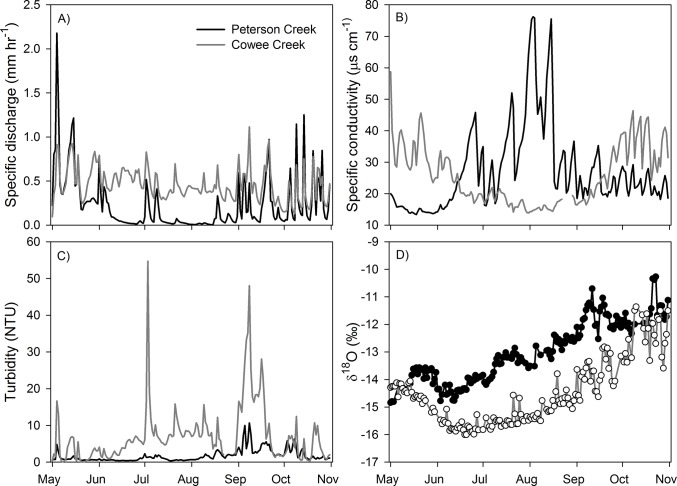
Time series of A) mean daily specific discharge (mm hr-1), B) δ18O values (‰), C) specific conductivity (μs cm-1) and D) turbidity (NTU) for the two study watersheds during the 1 May through 31 October, 2013 study period.